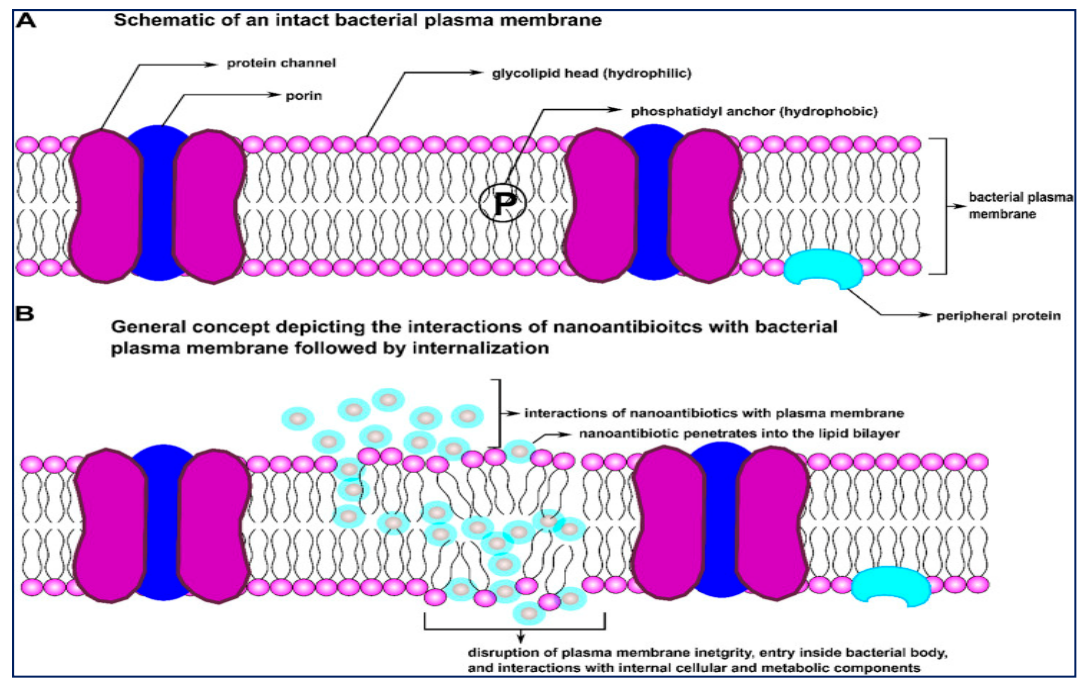
Figure 2. Schematic representation of ( A ) an intact bacterial cell membrane and ( B ) the effect of nanoantibiotics on the reliability of a bacterial cell membrane (Adapted from Ref. [96]).